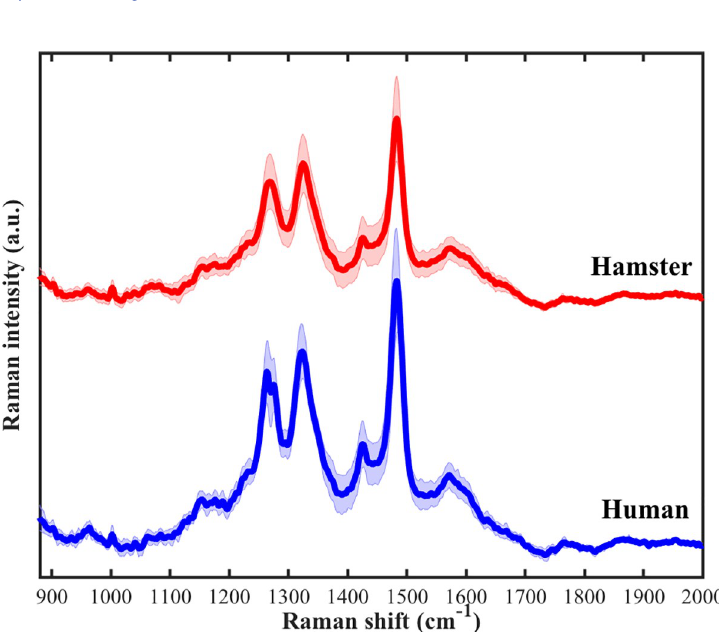
Fig 4. Comparison of averaged Raman spectra of O . viverrini eggs from the feces of hamster (n = 50) and of human subjects (n = 24). The solid lines and shaded areas represent means and standard deviations of the measurements (n = 50 for hamster and n = 24 for human).